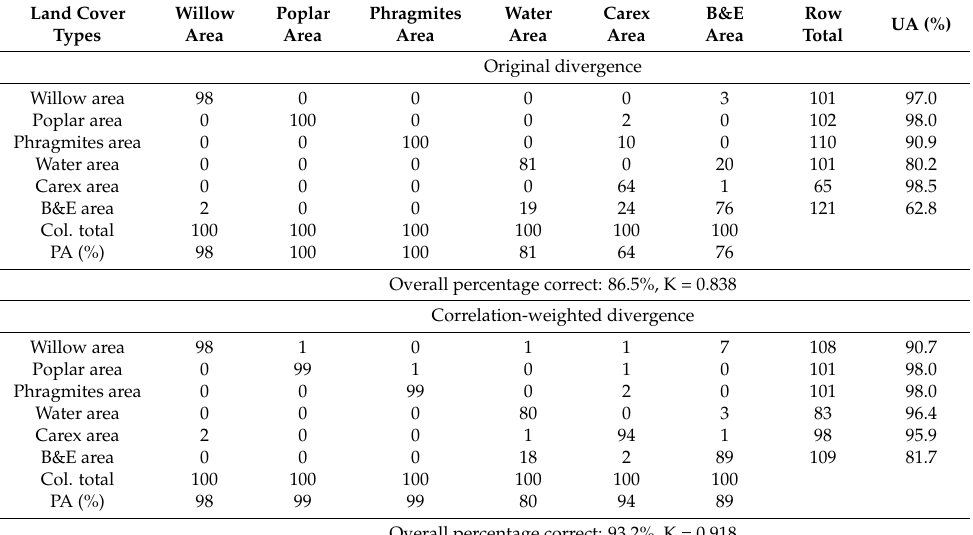
Table 3. Comparison of classification accuracy using Bayesian discriminant ( BD ) classifier between the original JM distance and correlation-weighted JM distance (Note: B&E: building and exposed; PA: producer accuracy; UA: user